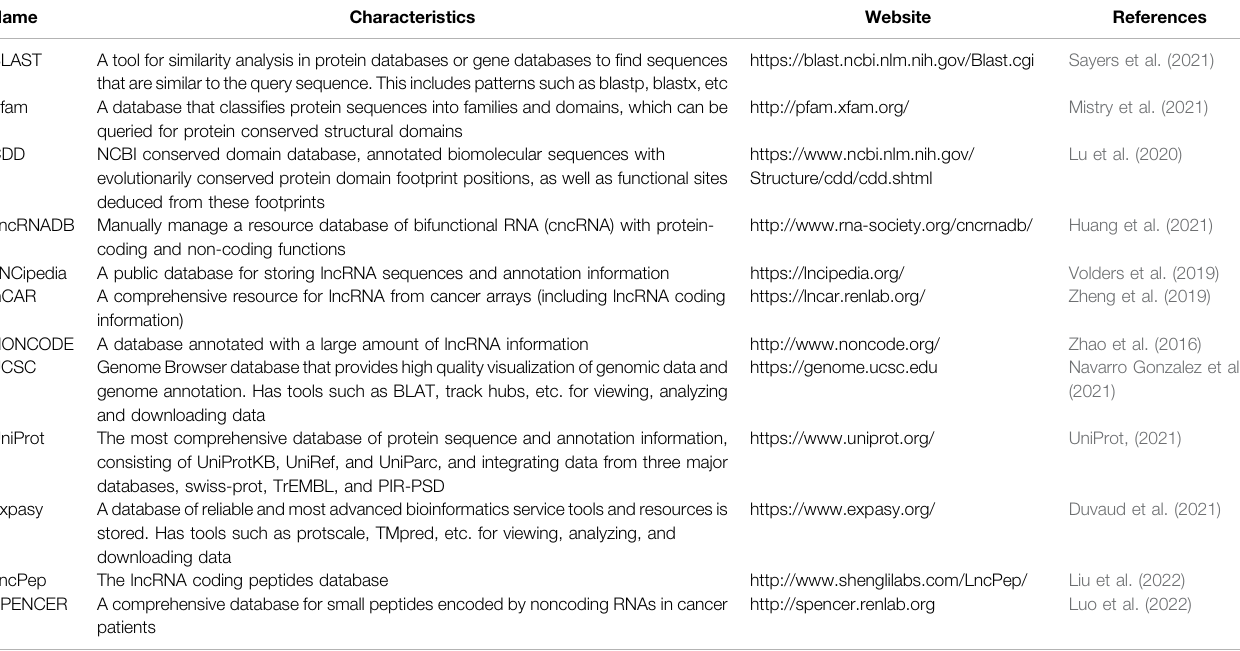
TABLE 4 | Commonly used databases for micropeptide